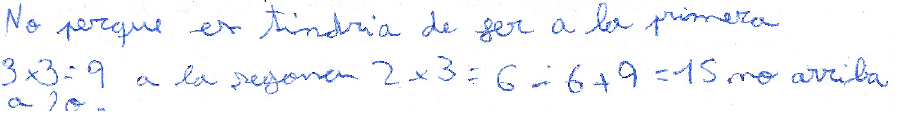
Figure 3. Incorrect answer of Q1. Wrong arithmetical strategy. CC1 cognitive conflict (translation: No, because you must do in the first 3 × 3 = 9 in the second one 2 × 3= 6 and 6 + 9=15 does not reach 20).